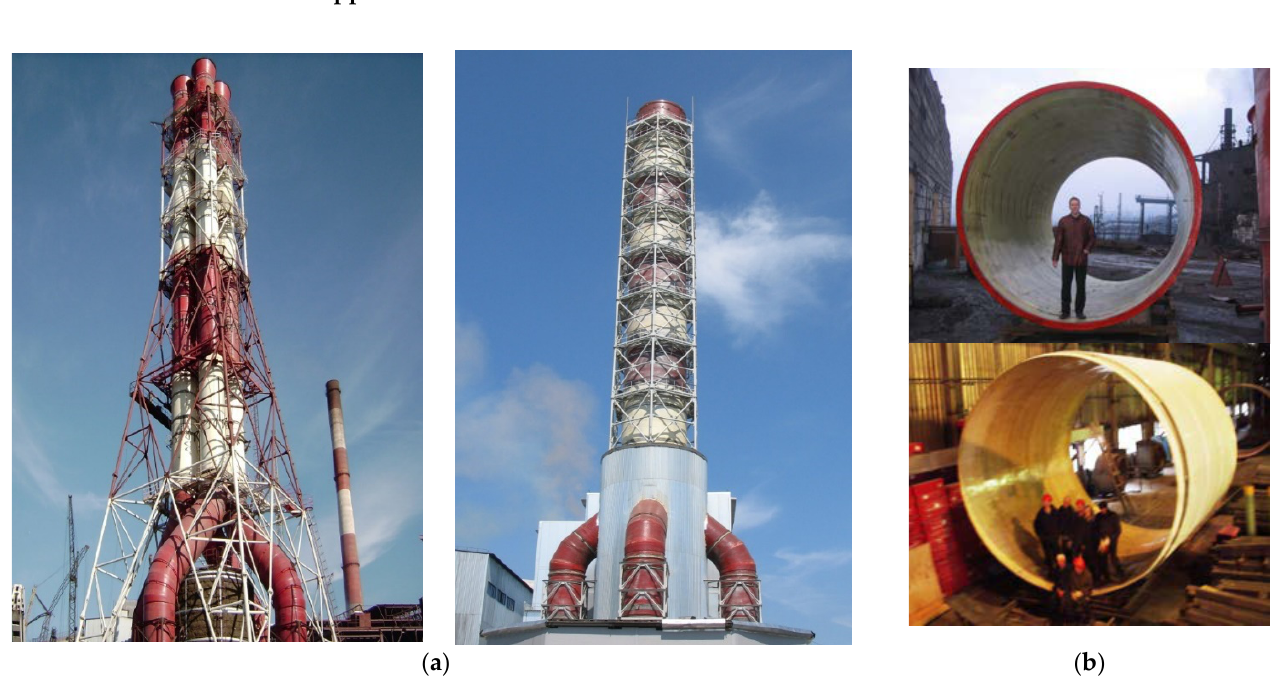
Figure A1. Examples of industrial gas exhaust ducts made of polymer composites: ( a ) fiberglass chimneys; ( b ) fiberglass shells for industrial gas ducts.